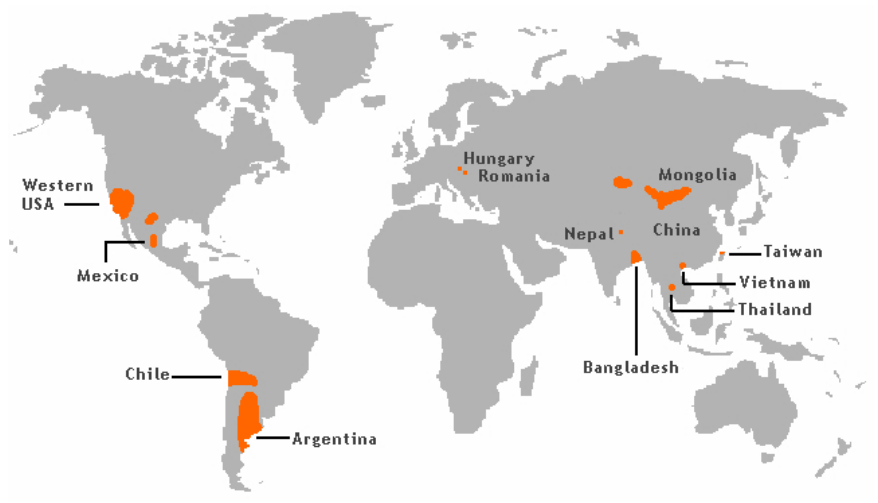
Figure 1. Arsenic risk areas around the world. From [20], Wikimedia Commons, the free media repository.